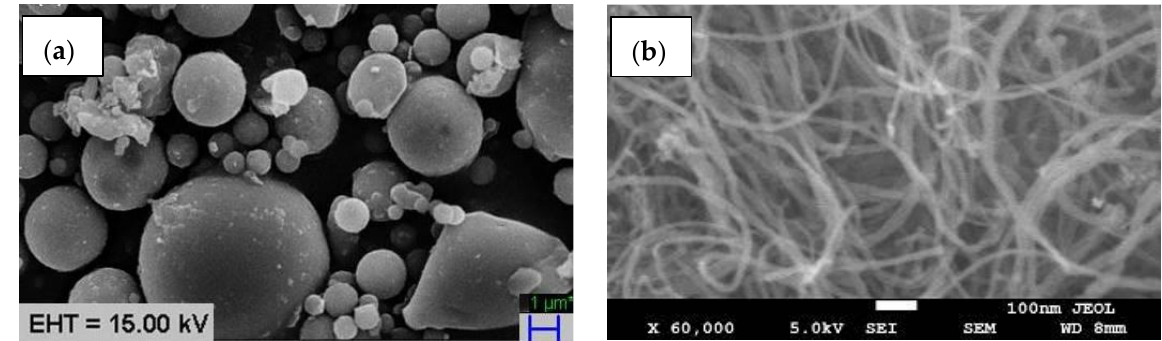
Figure 1. SEM images of the reinforcements: ( a ) fly ash and ( b ) CNT.